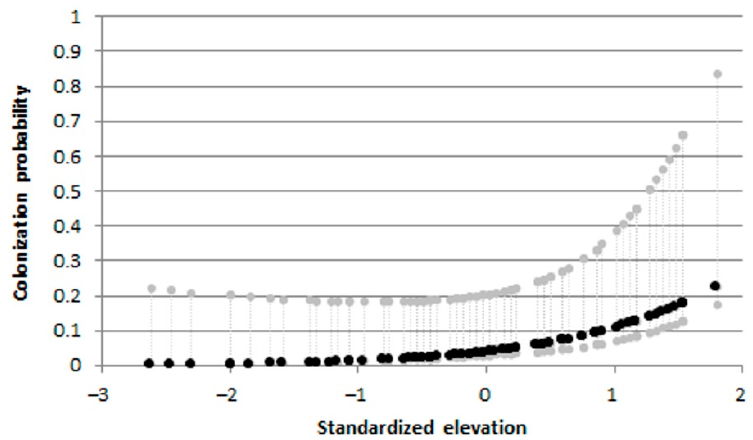
Figure 12. Padogobius bonelli : effects of elevation on colonization probabilities, from the best informative models . Dashed gray lines indicate upper and lower 95% confidence intervals.